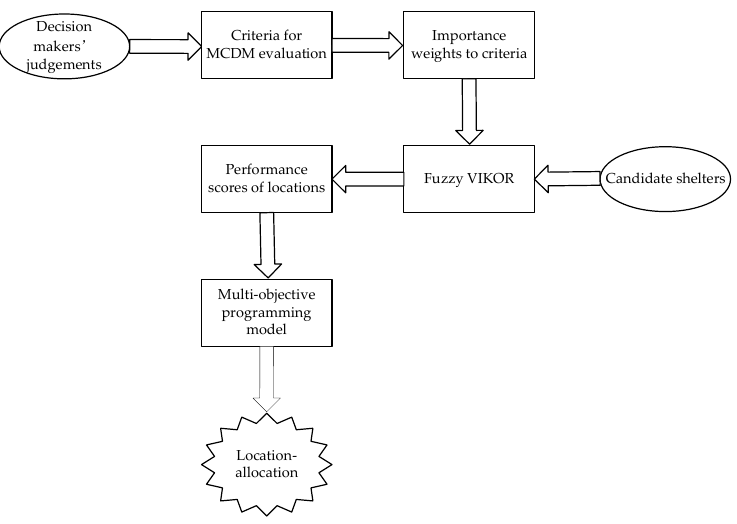
Figure 1. The integrated decision support model.